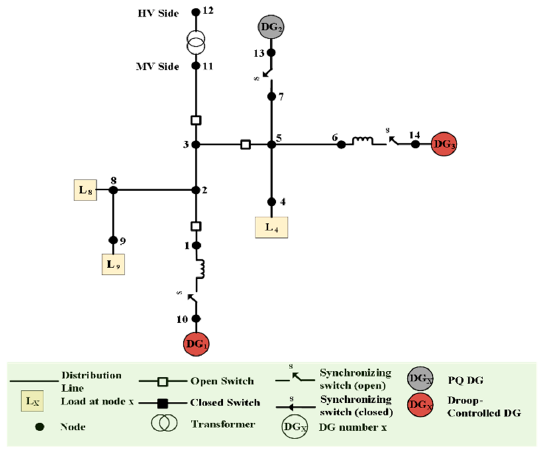
Figure 3. 14-Node distribution system waiting to be restored.